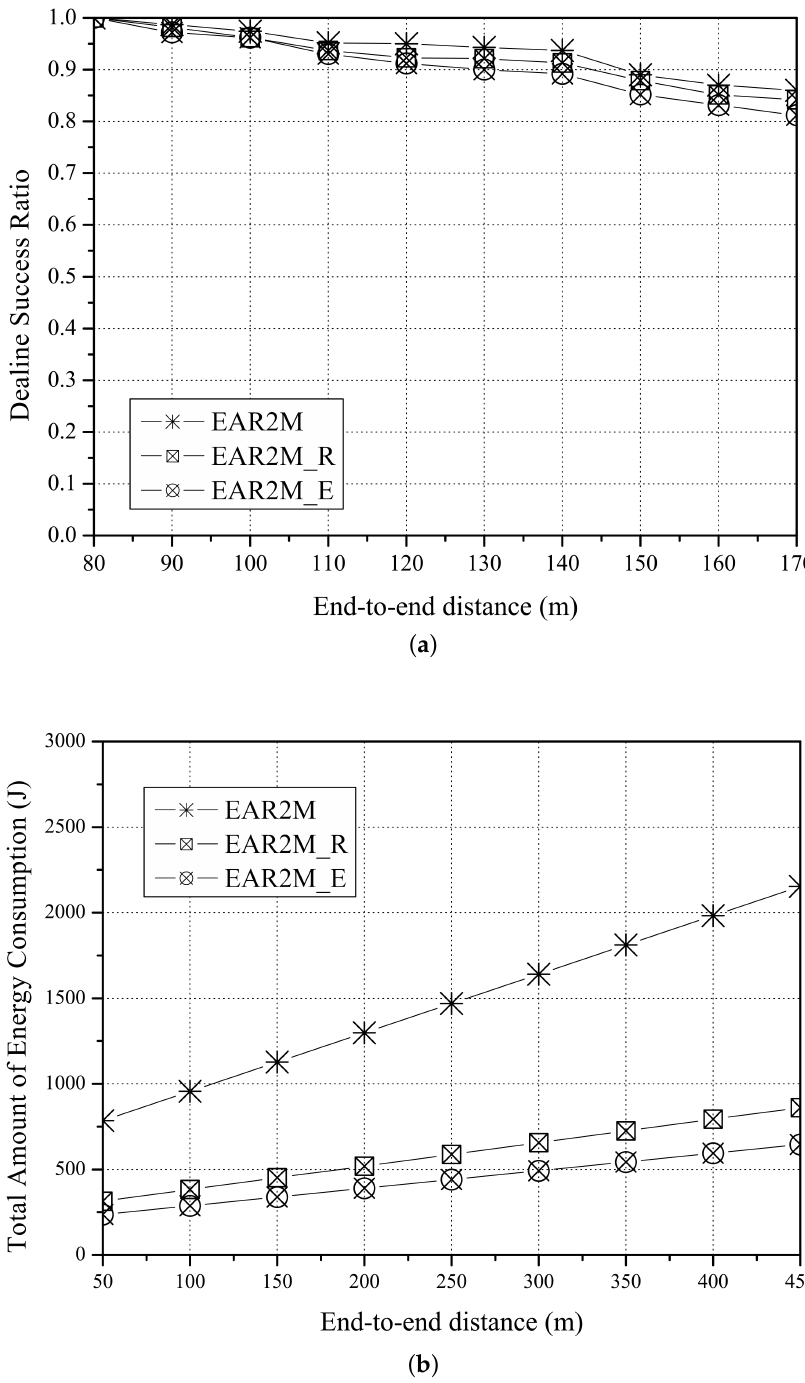
Figure 9. Performance comparison of the extended schemes according to end-to-end distance: ( a ) deadline success ratio and ( b ) energy consumption. Figure 10b indicates the energy consumption of the proposed schemes according to the sink speed. The extended schemes, EAR2M_R and EAR2M_E, reduce the energy consumption by merging the paths for unicasting and allowing relay via the